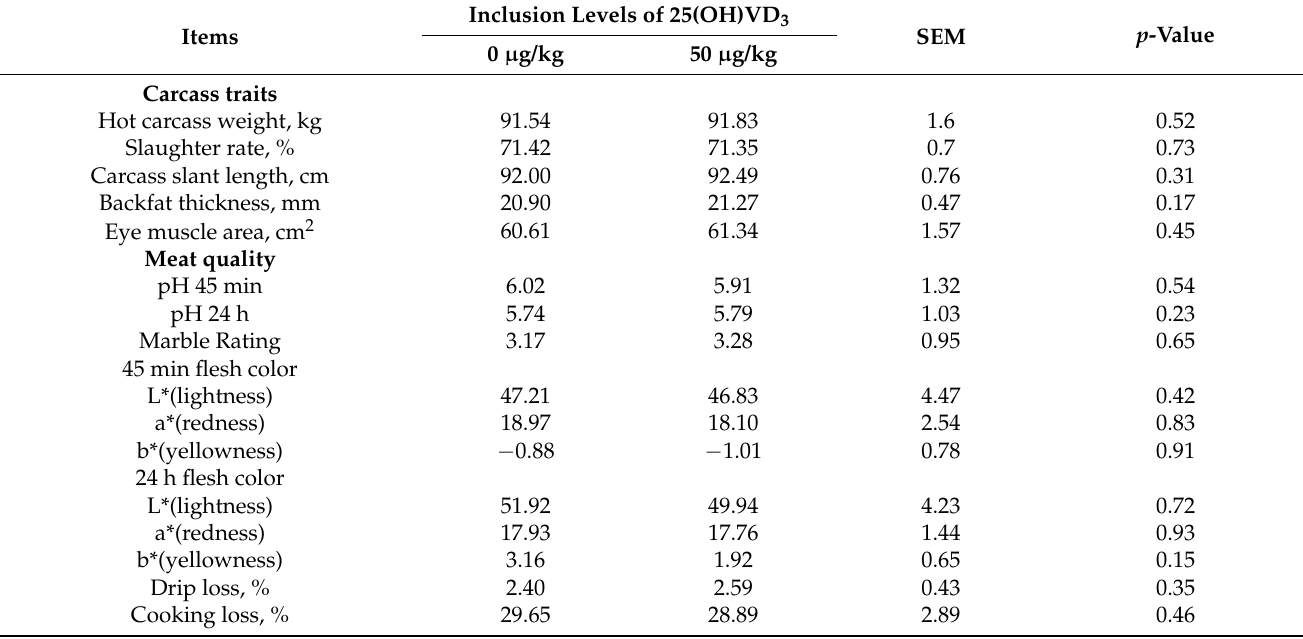
Table 4. Effects of the dietary addition of 0 and 50 µ g/kg 25(OH)VD 3 on the carcass traits and pork quality of growing- finishing pigs.